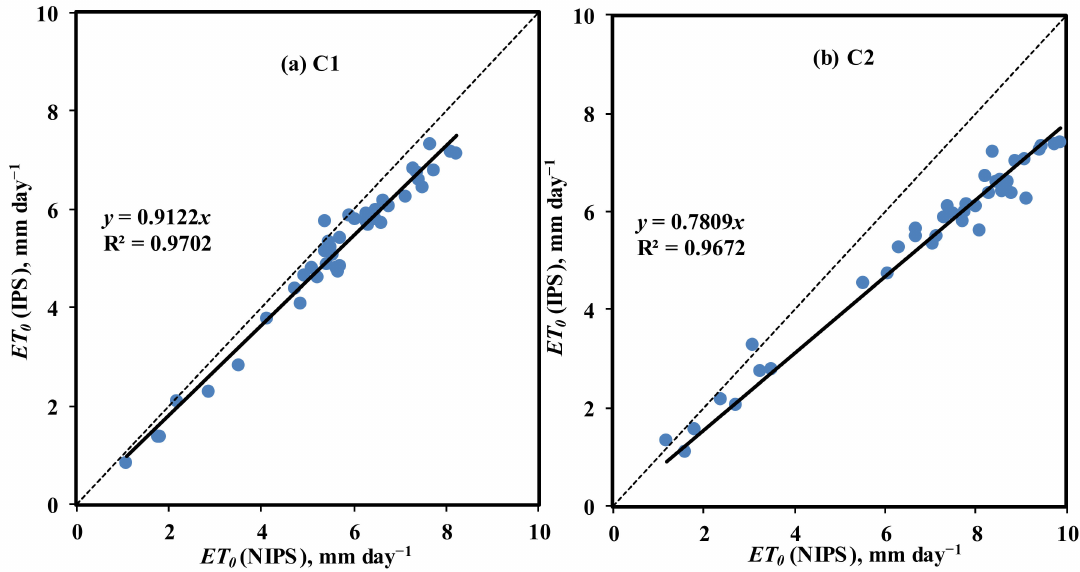
Figure 8. Relationship of ET 0 between IPS and NIPS treatments during C1 ( a ) and during C2 ( b ) of